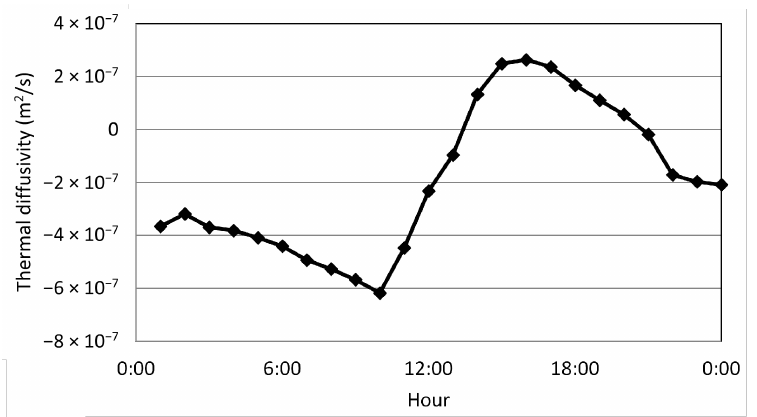
Figure 6. Calculated thermal diffusivity of surface patches for 3 February 2020. The recorded temperature change inside the wall, from which the thermal diffusivity was determined, is shown in Figure